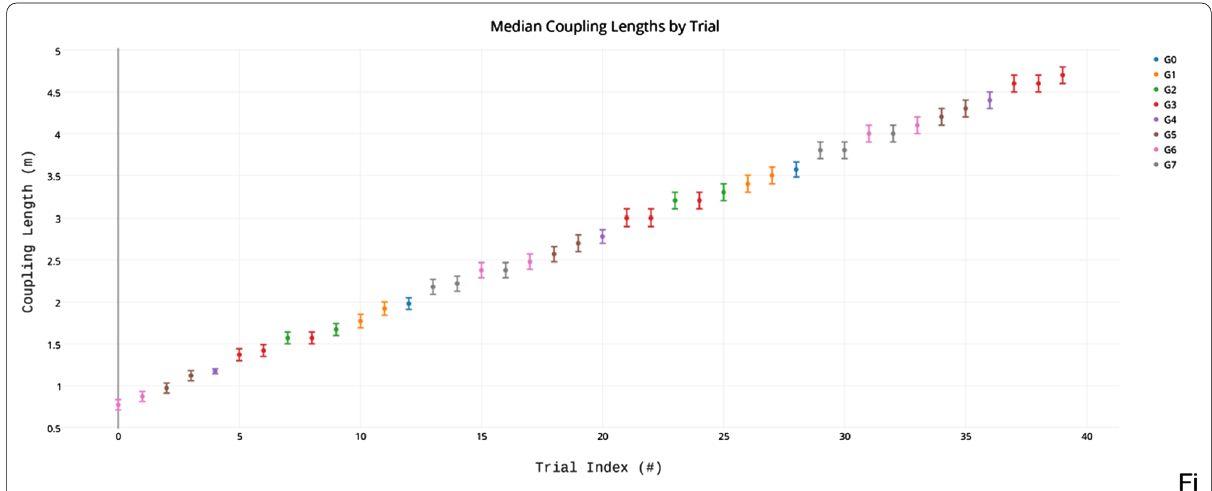
Fig. 16 Median Coupling lengths by trial. Note the color code indicating gait ( G0 – G7